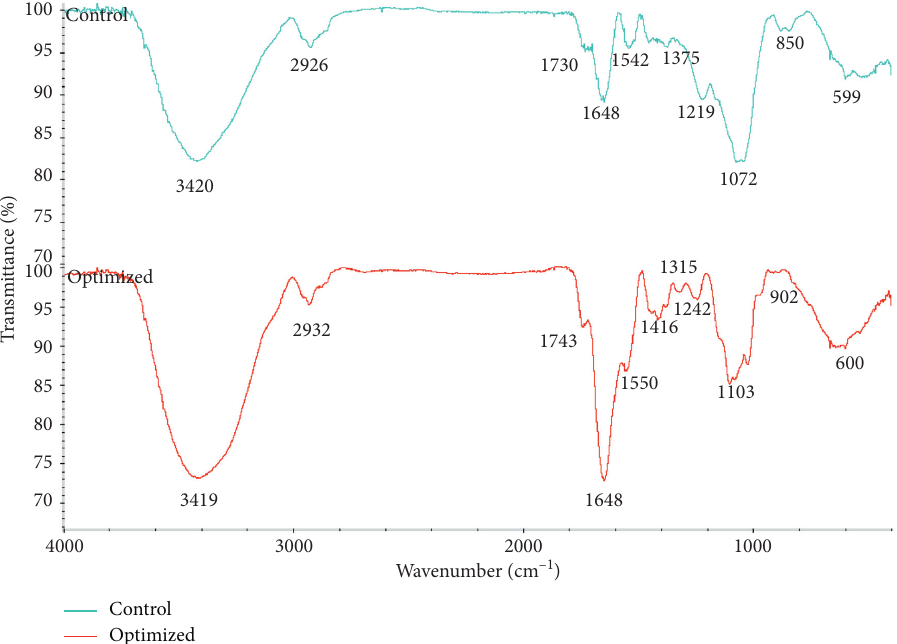
Figure 7: FT-IR spectra of FTP in the control and optimized group.